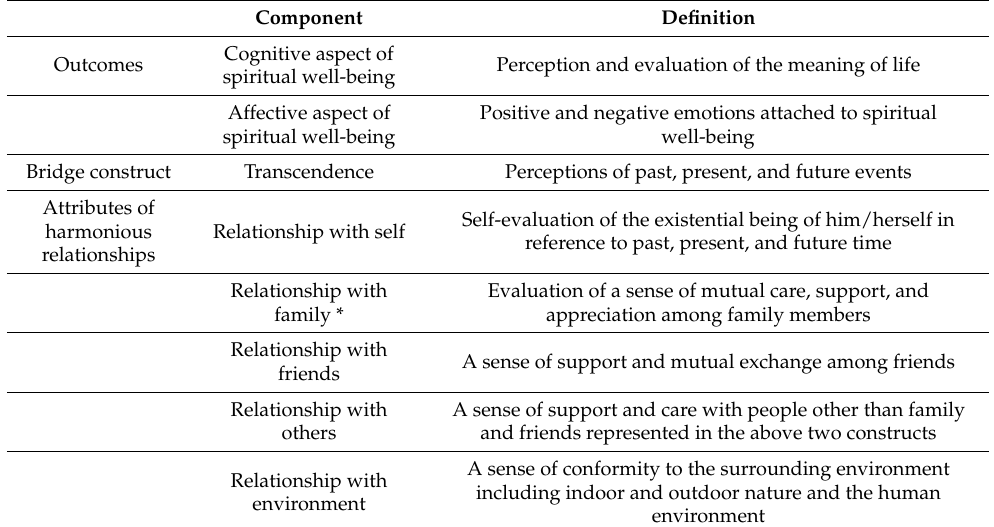
Table 1. Spiritual well-being conceptualization key